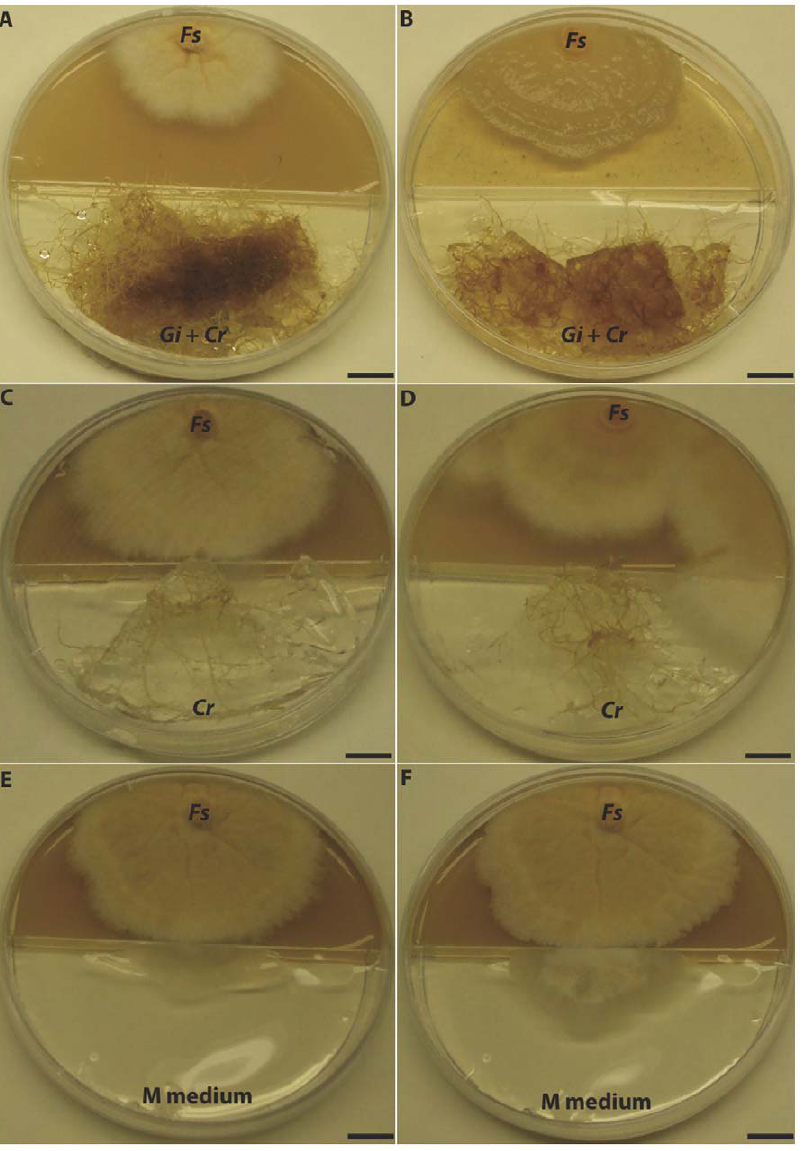
Figure 3. Confrontation cultures between G.irregulare and F.sambucinum . Experiments of confrontation between F. sambucinum and 2 isolates of G. irregulare DOAM-197198 (A) and DOAM-234328 (B) were performed in two-compartment Petri plates. Controls consisted of carrot roots without AMF (C & D) and M medium (E391 & F) without carrot roots or AMF.